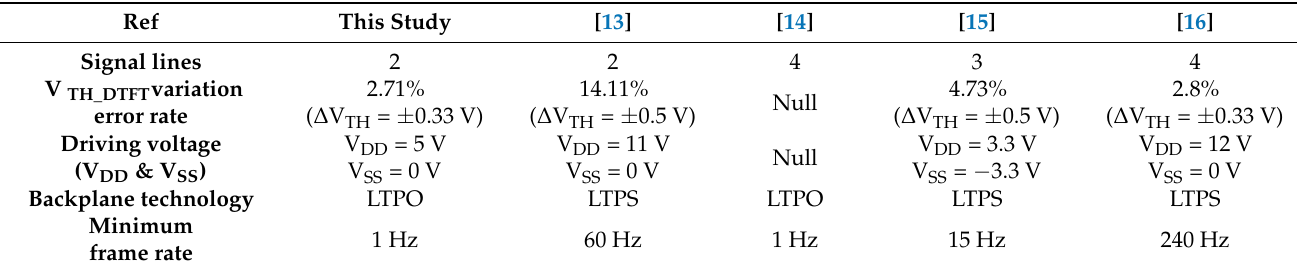
Figure 6. ( a ) OLED current variation with all-LTPS TFT and LTPO pixel circuit for 1 Hz frame rate ( b ) OLED current of high, middle, and low gray levels when the circuit is driven at 1 Hz.